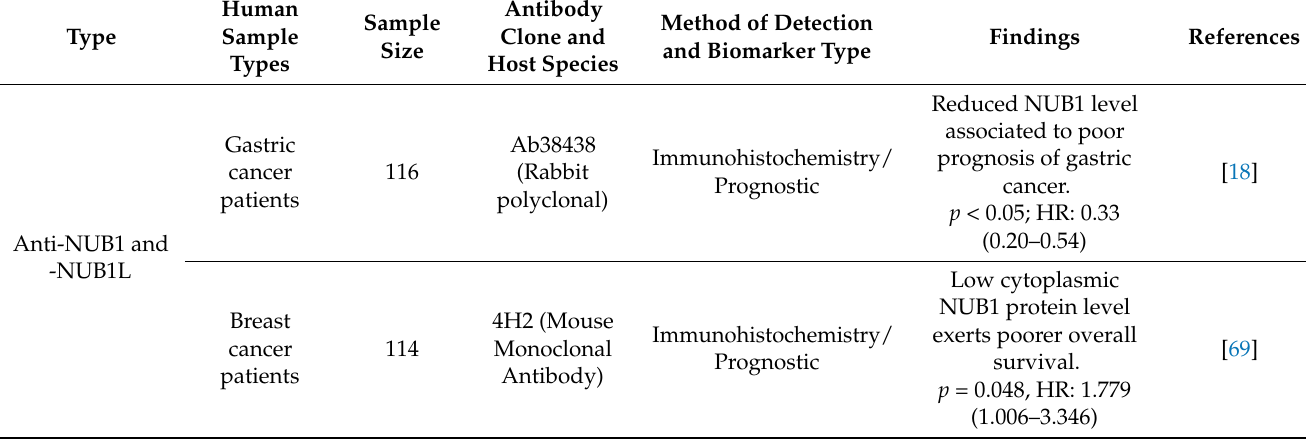
Table 2. Summary of translational NEDD8 ultimate buster 1 (NUB1) and F-adjacent transcript 10 (FAT10) studies that examine the correlation of protein expression to the survival probability of cancer patients. NUB1 and FAT10 protein statuses are identified as prognostic and potentially predictive biomarkers; NEDD8 ultimate buster 1 long (NUB1L); Non-small-cell lung cancer